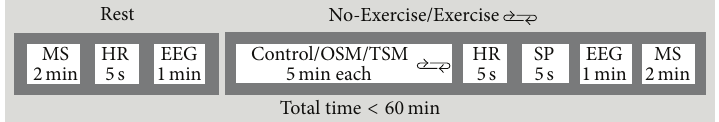
Figure 1: Randomized (indicated by rolling arrows) and controlled study design . Exercise and No-Exercise trials were conducted within three levels of virtual environment exposure (Control; OSM: one-screen mode; TSM: three-screen mode). Mental state (MS), heart rate (HR), sense of presence (SP), and EEG measurements were made at rest and following each trial.